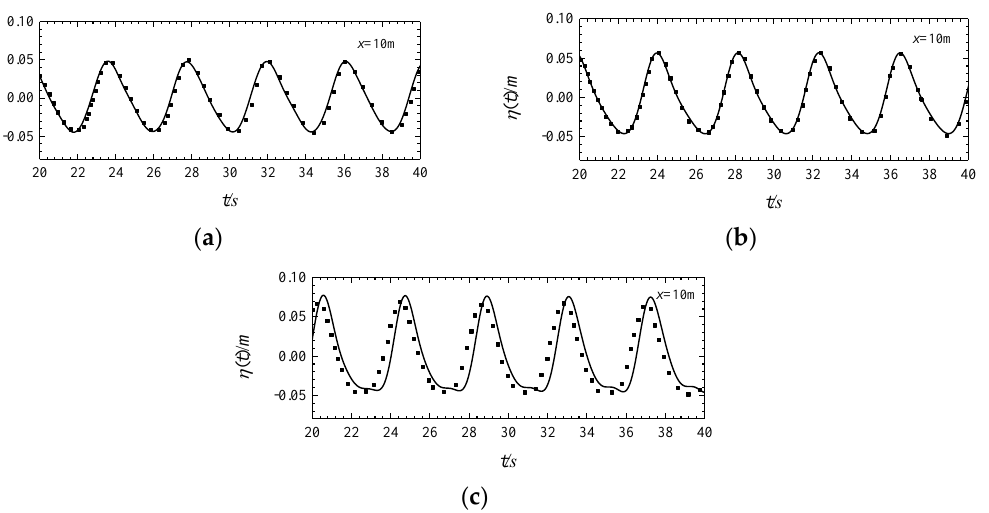
Figure 12. Wavefront ratio (at x = 10 m) of the MIKE 21 BW model (solid line) to the boundary element model ( ■ ) in downstream ( a ), no-current ( b ), counter-current ( c ) environment.